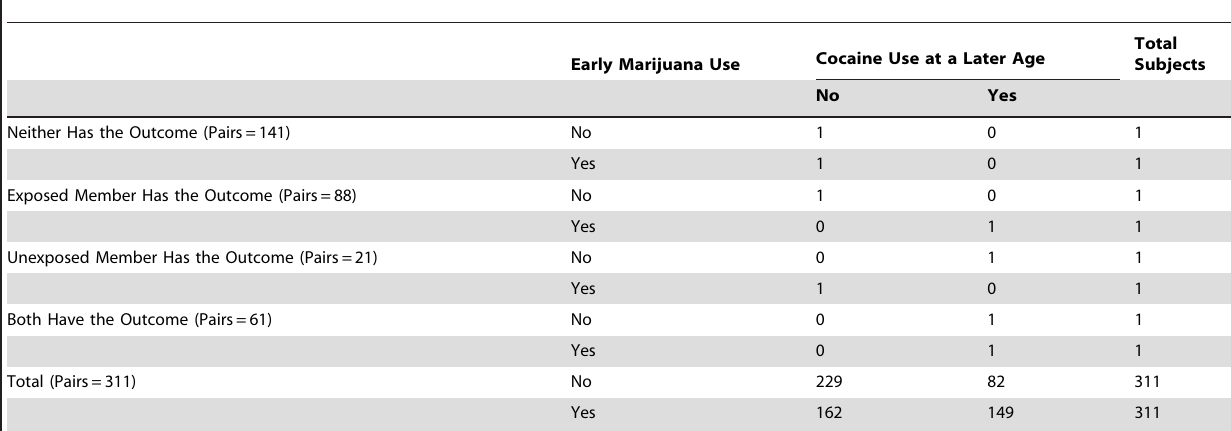
Table 4. Re-analysis of the subsequent cocaine use data for exposed twin members (early marijuana users) and their unexposed co-twins (non marijuana users) a .